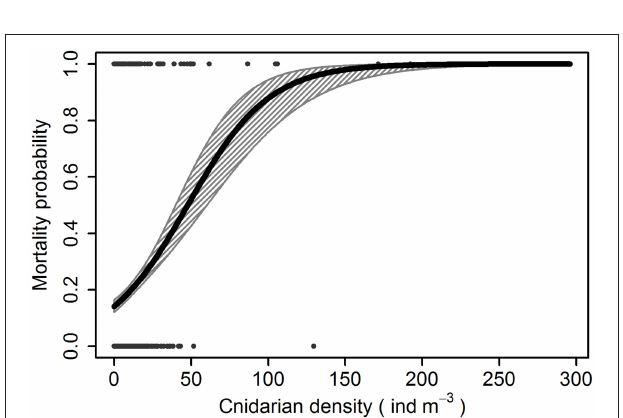
FIGURE 3 | Probability of a fish mortality event at different densities of cnidarians in the Almería facility. The dots at the top and bottom axes represent the mortality presence/absence over the monitoring.